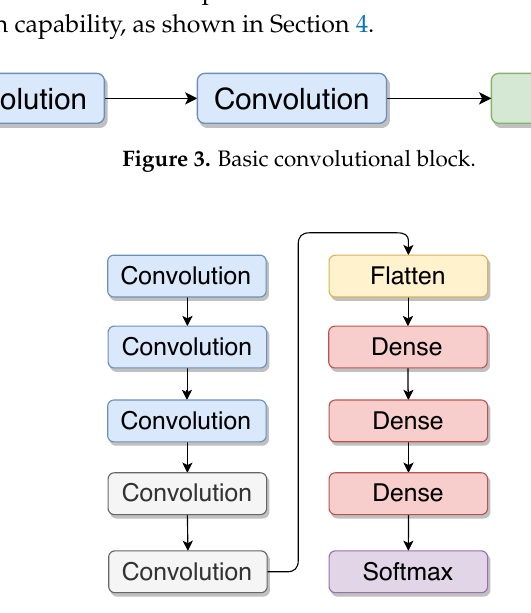
Figure 4. Basic convolutional neural network model architecture.